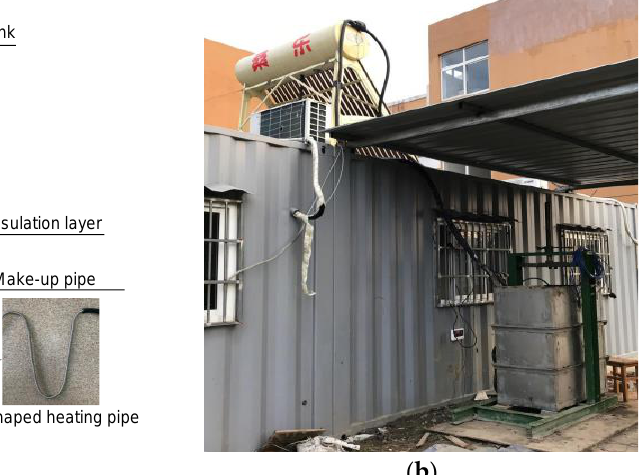
Figure 2. Schematic diagram of test model device. ( a ) Schematic diagram of test model device; ( b ) physical diagram of the test model device.